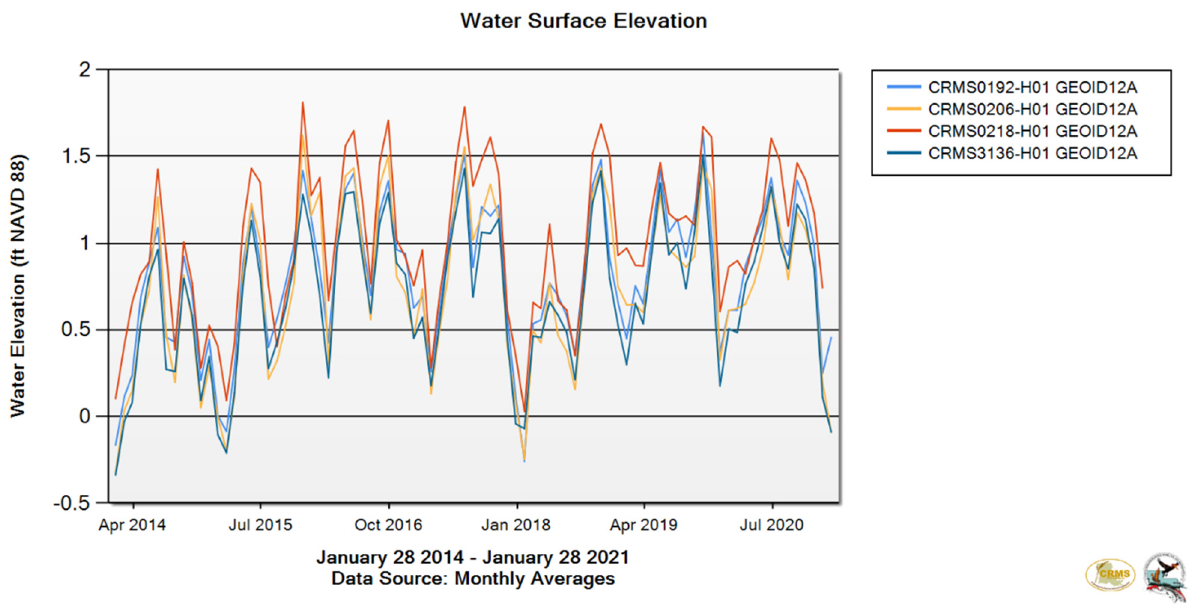
Figure 16. Stage gage records for four CRMS sites near Lac des Allemands swamp showing high water during 2016, 2019, and 2020 and very low water during 2018. The site with the highest stages depicts what the most flooded sites in Lac des Allemands swamp would look like prior to gapping.